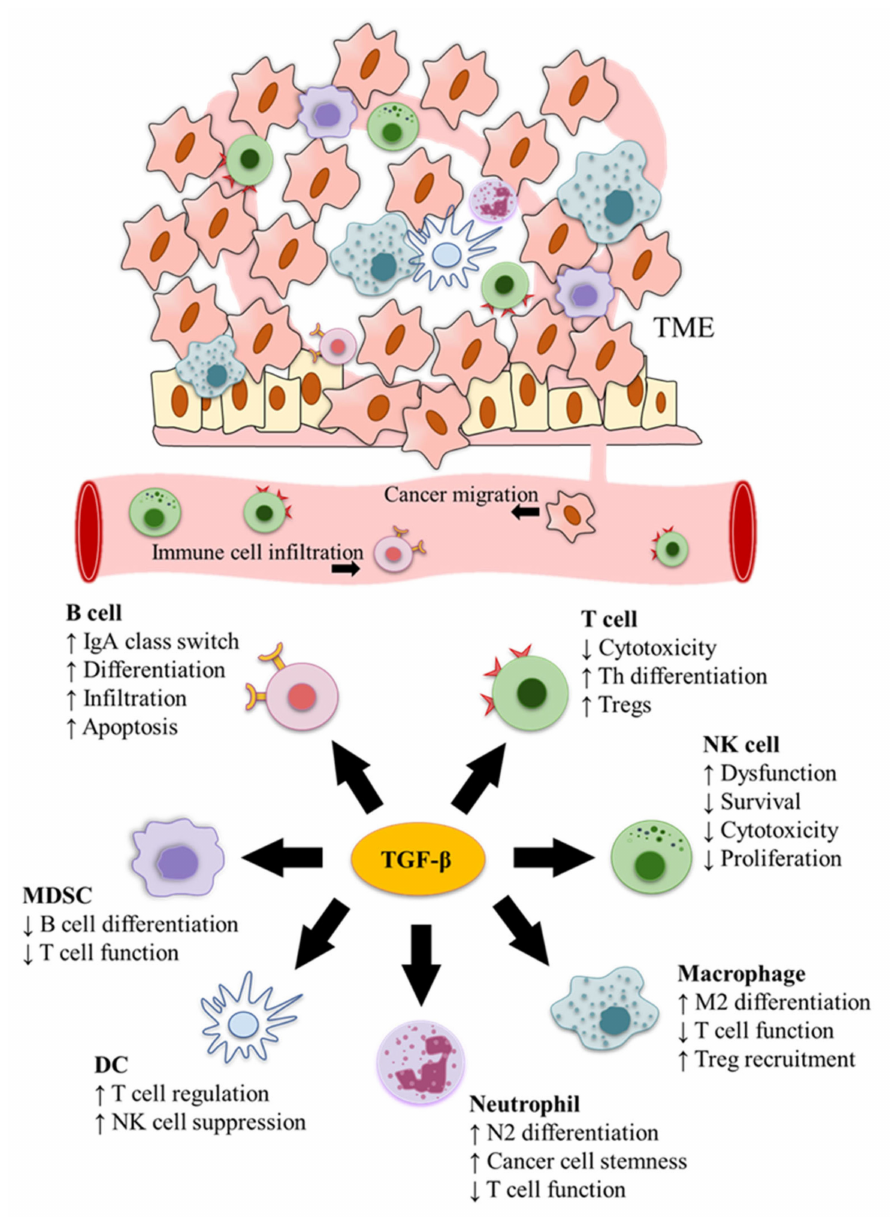
Figure 2. TGF- β functions in cancer immune surveillance. TGF- β modulates cancer immunity and has pivotal roles in the immunomodulation of the tumour microenvironment (TME) and di ff erent immune